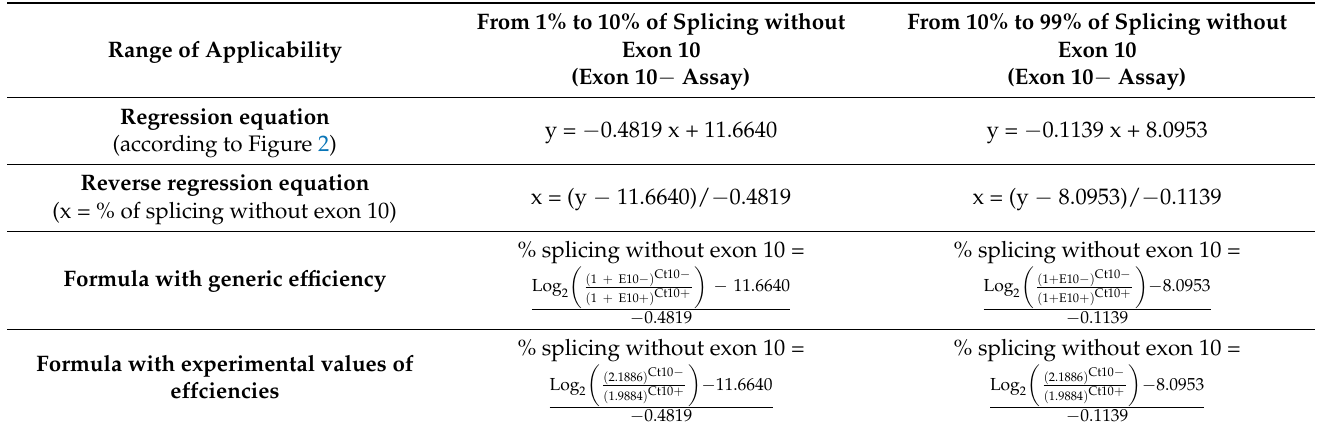
Figure 2. Reference plasmid curves and validation controls. Plasmidic reference curves of the measured logarithmic relationship between known proportions of plasmids containing exon 10 and plasmids not containing exon 10 (full squares) are shown. Also, validation controls with known ratio of exon 10+ and exon 10 − (empty circles) are shown, used to confirm the reliability of the method based on the reference curves. The leftmost curve (black squares) is used to estimate the percentages of splicing without exon 10 between 1% and 10%, with the formula y = − 0.4819 x + 11.6640, while the rightmost curve (grey squares) is used to estimate the percentages of splicing without exon 10 between 10% and 99%, with the formula y = − 0.1139 x + 8.0953. Table 2. Formulas for the calculation of the percentages of splicing without exon